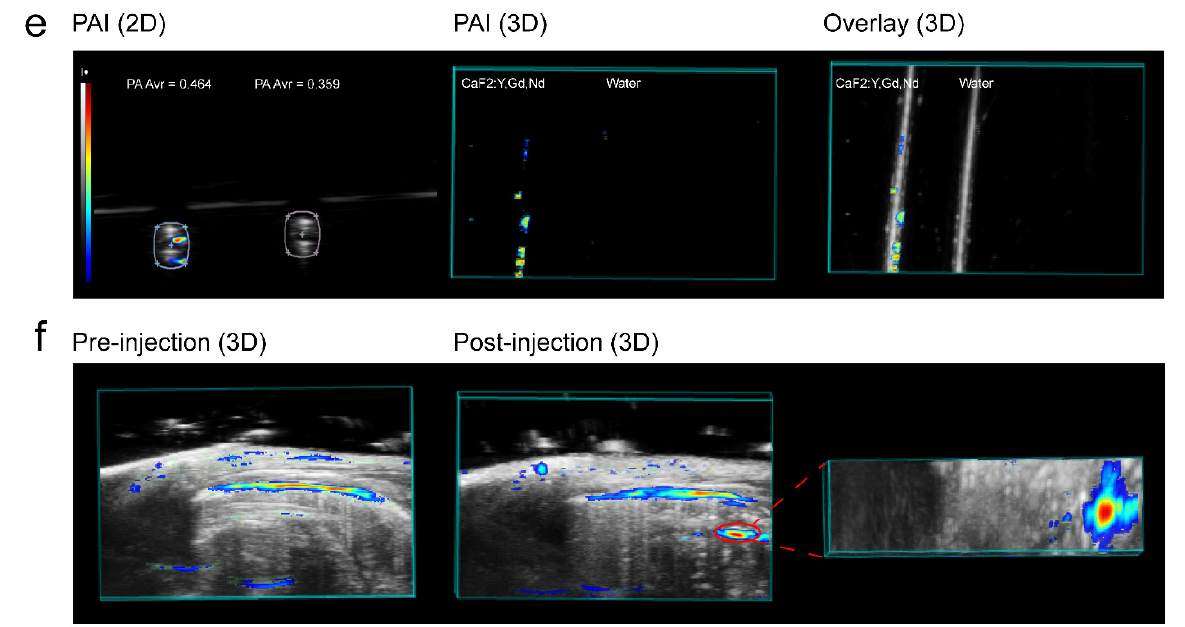
Figure 8. MRI and PAI performance of CaF 2 :Y,Gd,Nd NPs. ( a ) The VSM measurement of CaF 2 :Y,Gd,Nd NPs; ( b ) MRI signal intensity of different concentrations of CaF 2 :Y,Gd,Nd NPs with increasing recovery time; ( c ) in vitro T1 relaxation rates of different CaF 2 :Y,Gd,Nd NP concentra- tions; inset shows T1-weighted MRI images of CaF 2 :Y,Gd,Nd NPs at different concentrations in 0.5% agarose gel; ( d ) ex vivo MRI images before and after subcutaneous injection of CaF 2 :Y,Gd,Nd NPs (10 mg/mL) into a mouse cadaver; ( e ) in vitro PA images (2D and 3D) of CaF 2 :Y,Gd,Nd NPs (10 mg/mL), water is the control; ( f ) ex vivo PA images (3D) before and after injection of CaF 2 :Y,Gd,Nd NPs (10 mg/mL) into a mouse. Unspecific signal is caused by endogenous tissue